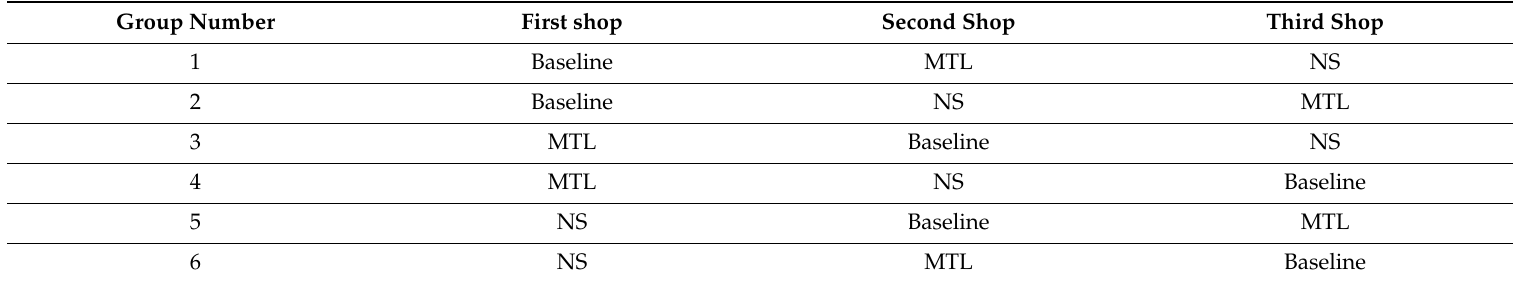
Table A8. Six intervention sequences via random permuted blocks of size three with equal